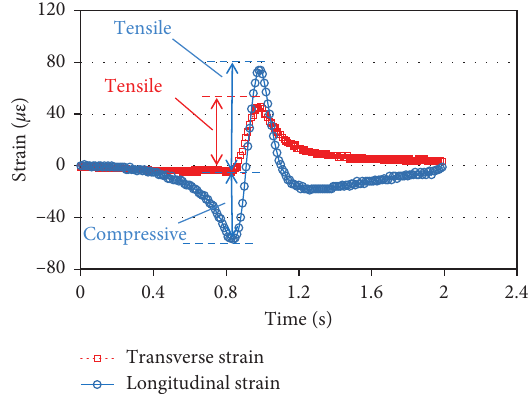
Figure 5: The typical transverse and longitudinal strain pulses of semirigid